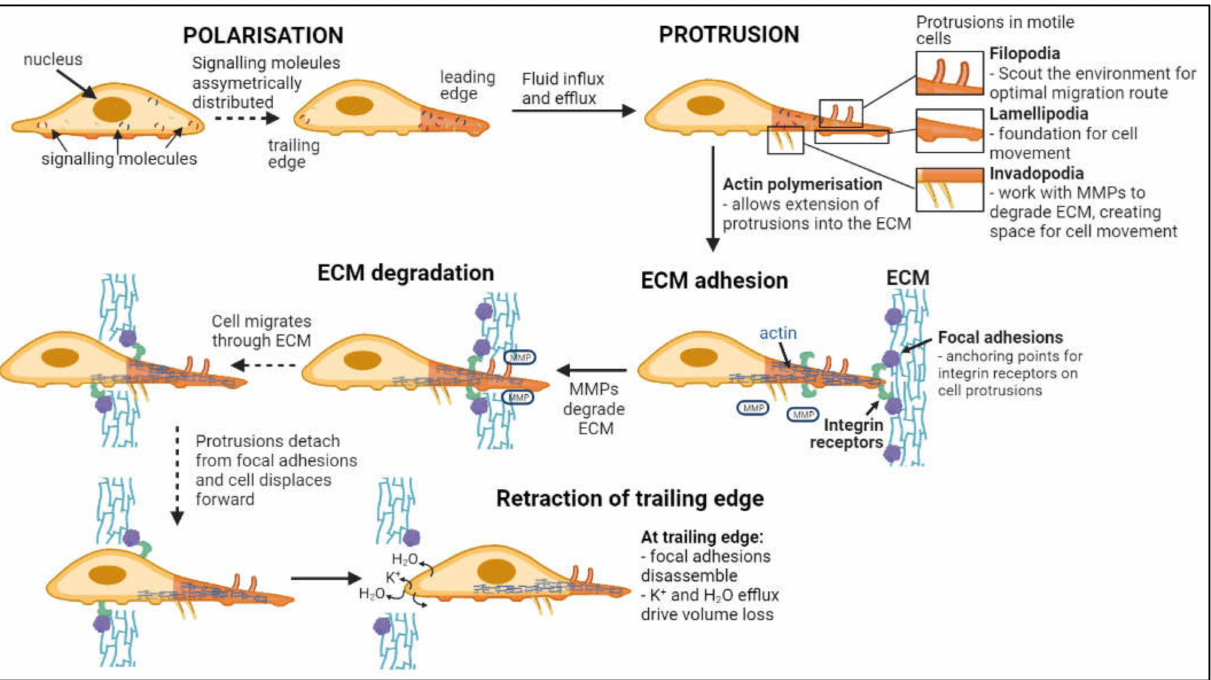
Figure 2. Flow chart of steps in cell invasion. Leading and trailing edges of cells form following asymmetric distribution of signaling molecules [71,72]. Fluid influx and efflux at the leading edge drives the formation of protrusions while actin polymerization facilitates extension into the ECM [73–77]. Focal adhesion proteins within the ECM bind integrin receptors on the cell surface, anchoring the cell to the ECM while metalloproteinases (MMPs) degrade the ECM [78,79]. Continuous detachment and reattachment of these anchorage points allows forward displacement of the cell through degrading ECM [80,81]. Complete disassembly of focal adhesion points and volume loss at the trailing edge terminates cellular invasion